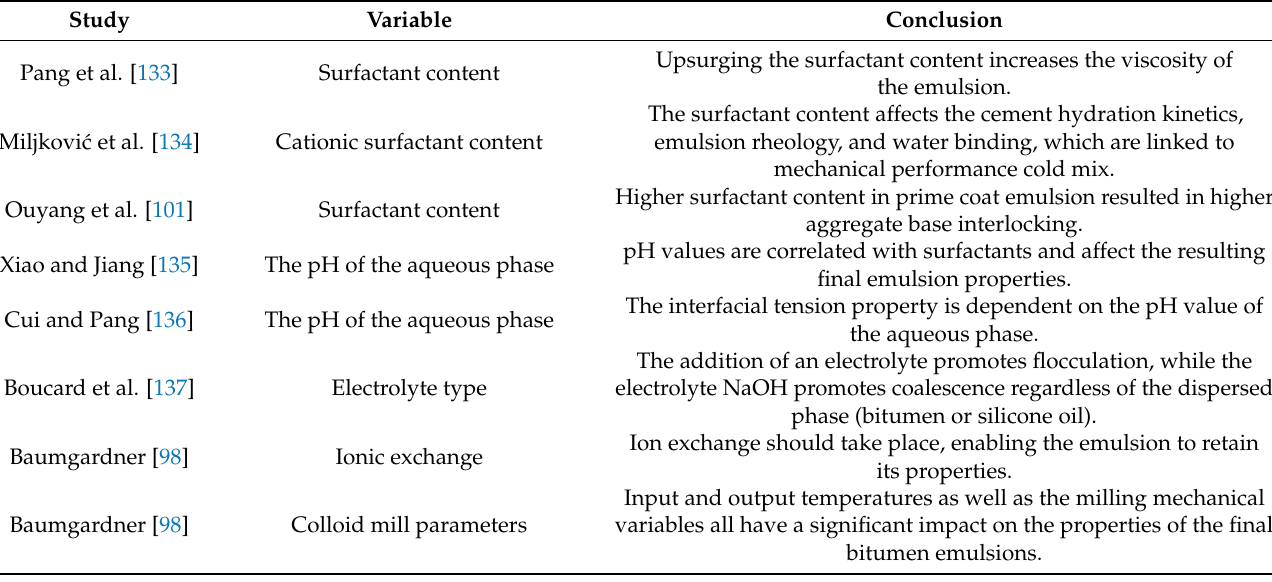
Table 2. Summary of studies on bitumen emulsion formulation